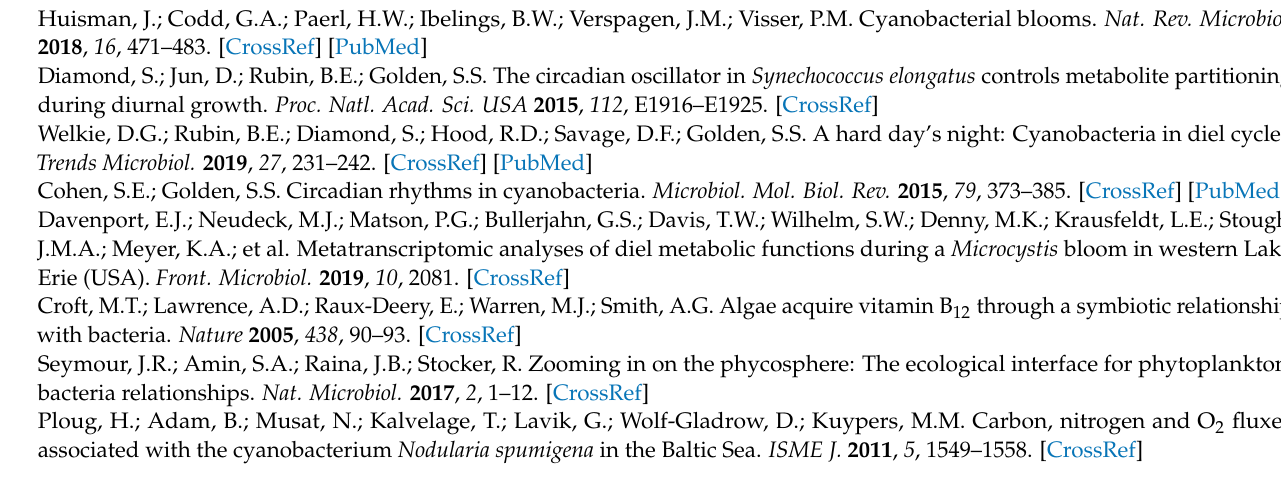
Figure S2: Measured physicochemical variables of Lake Erie and the microcosm samples. Figure S3: The expression pattern of Microcystis genes between the Microcystis (MCY) and whole water (WW) samples. Figure S4: Averages of the normalized Microcystis gene expression values. Figure S5: The expression pattern of the microbiome genes between the microbiome (MIB) and whole water (WW) samples. Figure S6: Microbiome communities identified in the MIBs and